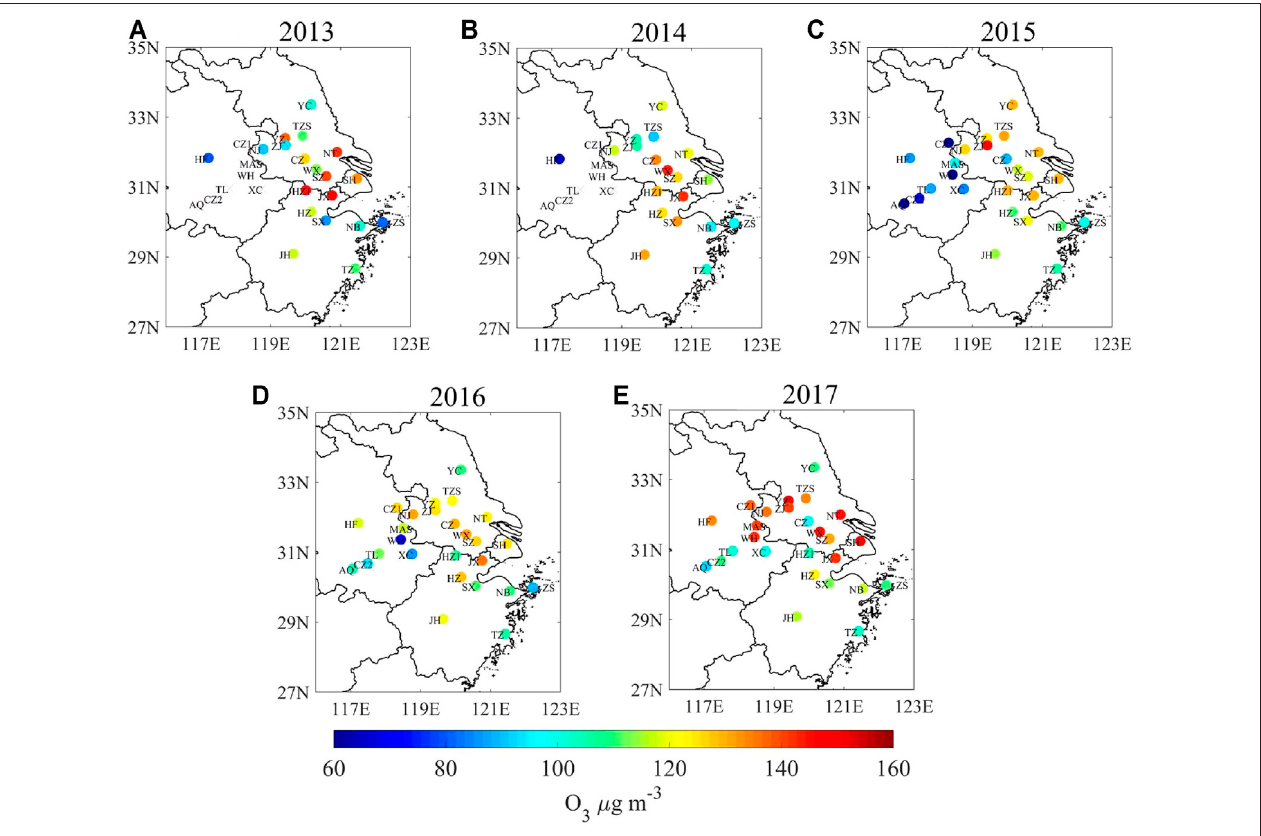
FIGURE6| ThespatialdistributionofsummeraverageMDA8O 3 intheYRD,including (A) 2013, (B) 2014, (C) 2015, (D) 2016,and (E) 2017.Thepurplexsymbols in (A) and (B) indicate that there are no data.